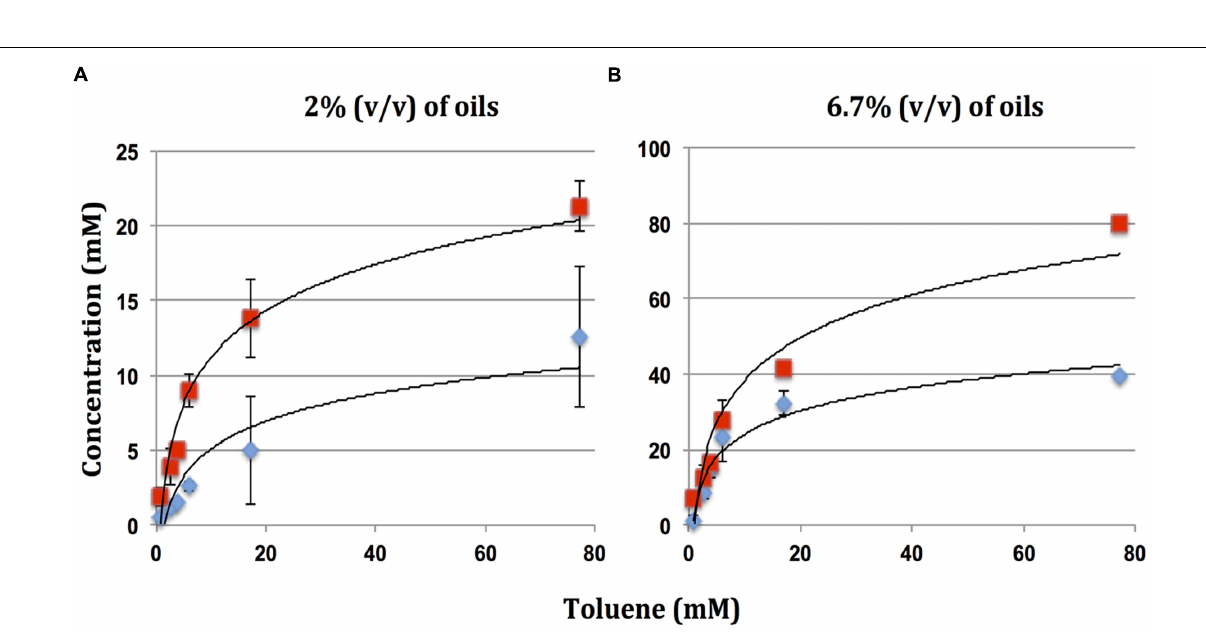
Frontiers in Microbiology |